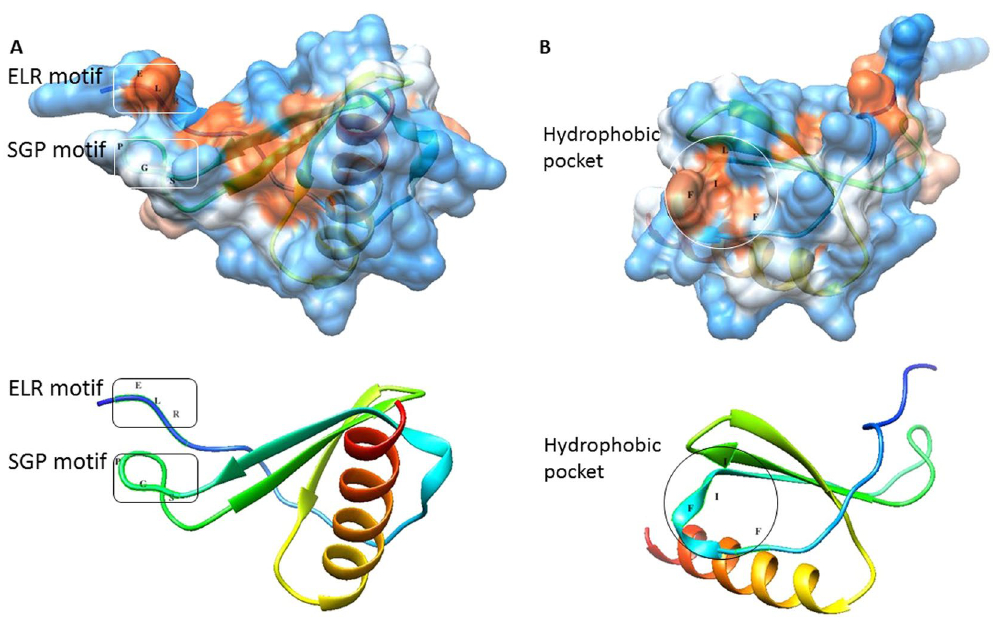
Figure 4. Structural model of modeled human IL-8, wherein panel A shows two conserved sequence motifs, ELR 31–33 and SGP 57–59 , that face each other and form a structural scaffold putatively involved in IL-8 binding to its receptor; and panel B shows the hydrophobic pocket formed of F 44 , F 48 , I 49 and L 70 on the surface of IL-8 protein having role in receptor